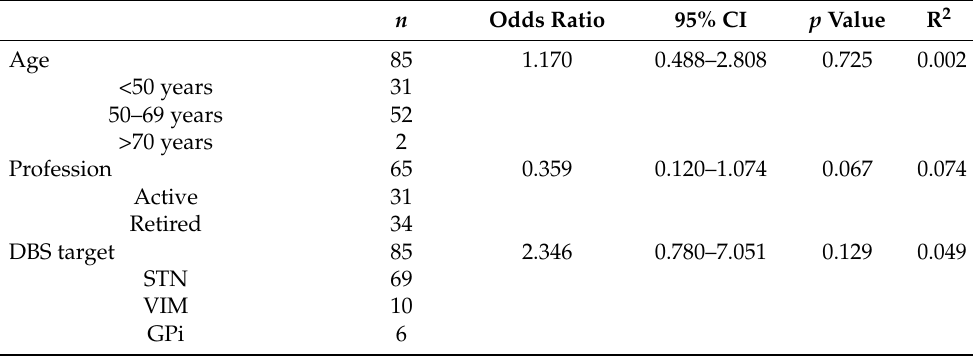
Table 3. Univariate regression results of the potential epidemiological risk factors influencing driving post